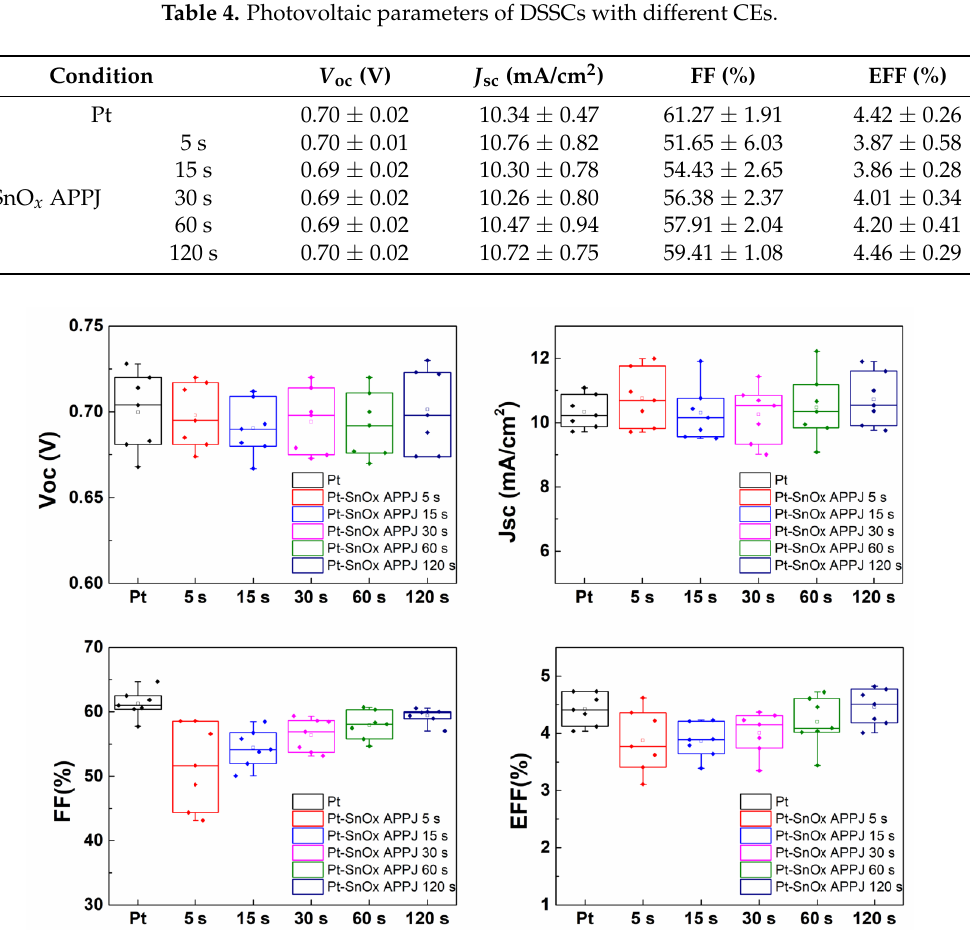
Figure 8. Statistics of DSSC parameters based on APPJ-processed Pt-SnO x CEs and furnace-processed Pt CE (reference).